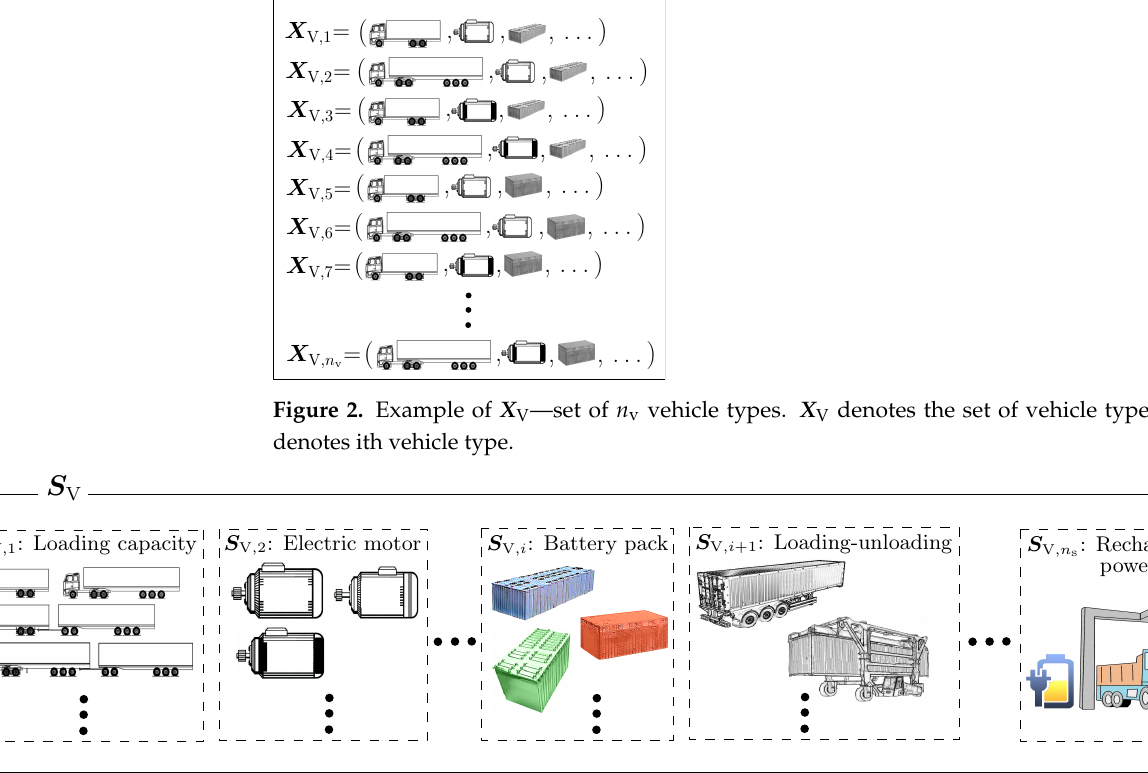
Figure 3. Example of design space S V together with vehicle and infrastructure design sets. n s denotes total number of design sets. S V, k denotes kth design set (or the range of kth design